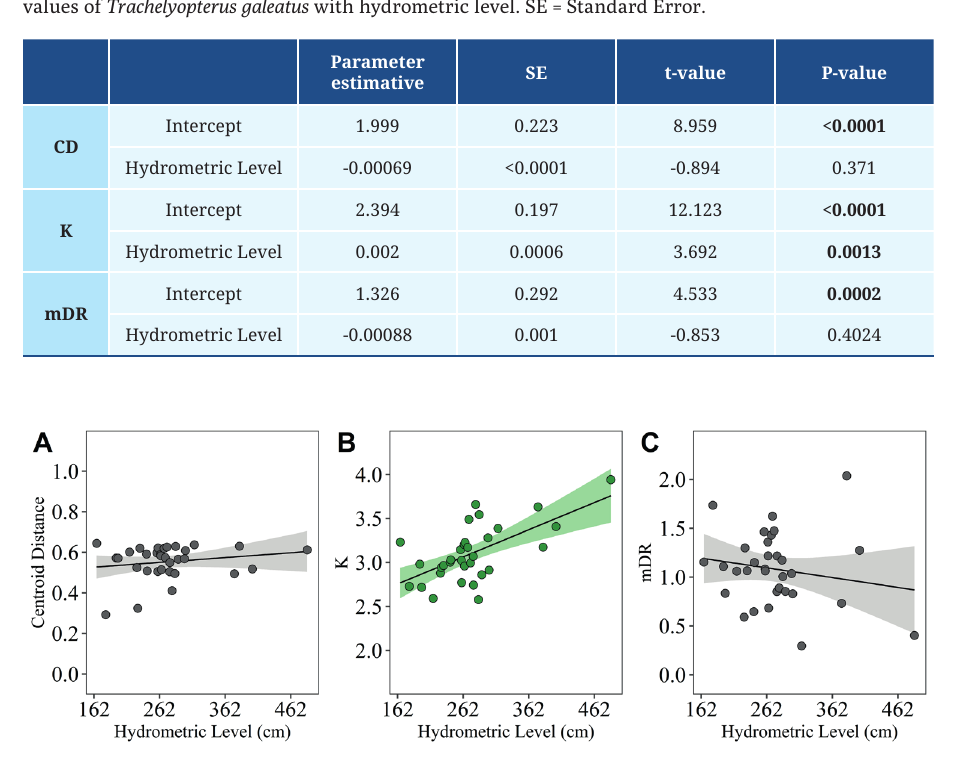
FIGURE 5 | A. Relationship between the hydrometric level and the trophic niche breadth; B. Body condition; C. And the feeding activity of Trachelyopterus galeatus . The green graphs indicate a significant positive influence of the variable as a function of hydrometric level, while grayscale graphs indicate a